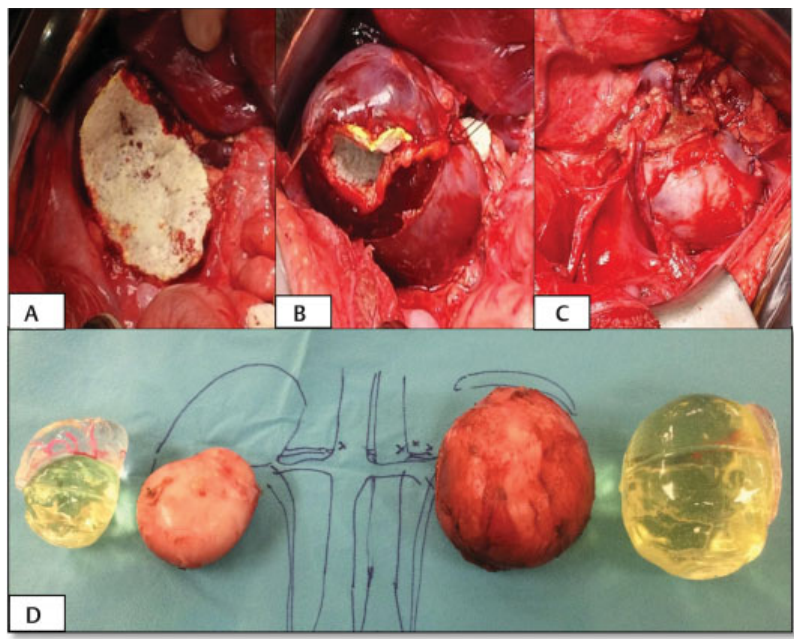
performed with adhesive matrix and plication of the renal parenchyma. In the image ( D ), the resected specimens are shown together with their corresponding three-dimensional models, objectifying the great similarity between both.